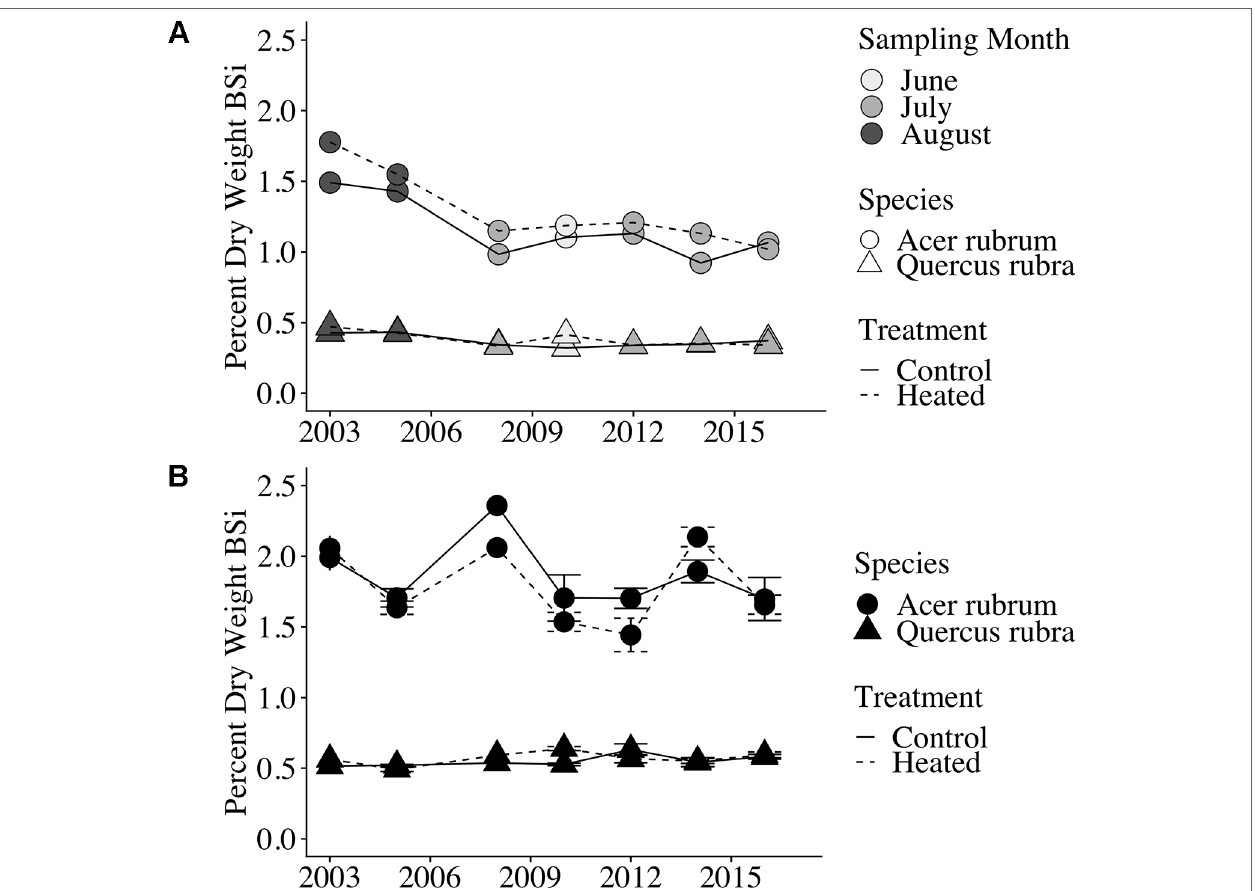
FIGURE 2 | Foliar and litter BSi concentrations over time. (A) Foliar (green leaf) BSi concentrations. Point shape indicates species, line type indicates treatment, and point weight indicates the month of sample collection. Samples were collected during August in the first 2 years analyzed; samples were collected in June or July in all subsequent years analyzed. Error bars are not shown because only a single bulked sample was available per plot × year. (B) Leaf litter silica concentrations (percent dry weight BSi) are shown for each of the 7 years of analyzed samples; error bars indicate standard error of the mean. All samples were bulked across the duration of litterfall for the given year.